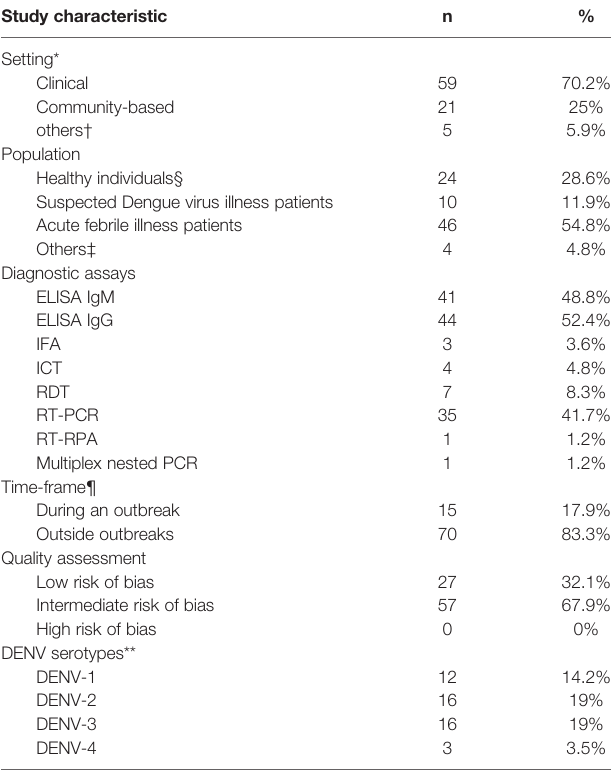
singleserotype,orinthecaseofserotypecon fi rmationbypolymerasechainreaction,virus neutralization test, isolation of the virus and sequencing of viral nucleic acid. ELISA, enzyme-linked immuno-sorbent assay; ICT, immunochromatography assay; IFA, immuno fl uorescence assay; RDT, rapid diagnostic test; RT-PCR, reverse